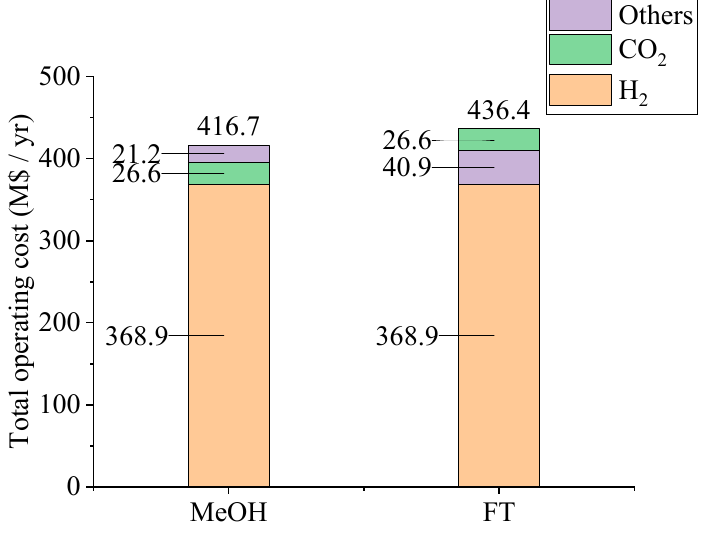
Figure 3. Total operating cost breakdown of methanol synthesis and Fischer–Tropsch process models.